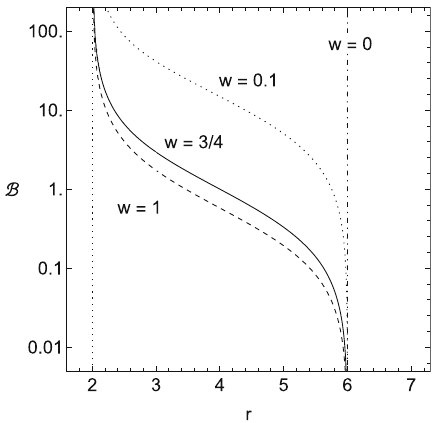
values of the MF parameter B , while the points of these curves show the position of stable off-equatorial circular orbits. The dotted curve represents the offISCO for charged particles in the off-equatorial plane, while the dashed curve shows the corona/jet boundary